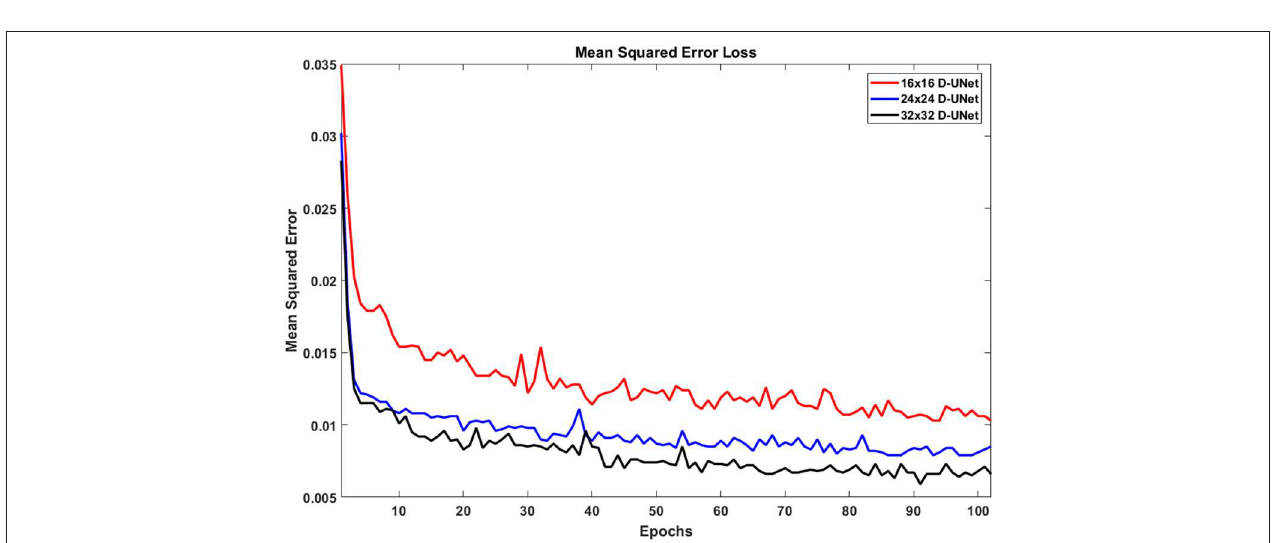
FIGURE 4 | The loss functions for the 16x16 D-UNet (red), 24x24 D-UNet (blue), and the 32x32 D-UNet (black) are shown. All three loss functions drop significantly in the first 2 epochs, and then gradually decrease as the training continues. Overfitting is not an issue with the current training method, because each epoch contains a new set of 1,000 data. Therefore, the network does not see any dataset more than once. While more epochs could be used, the loss function flattens after 70 epochs, which implies that further training will yield minimal